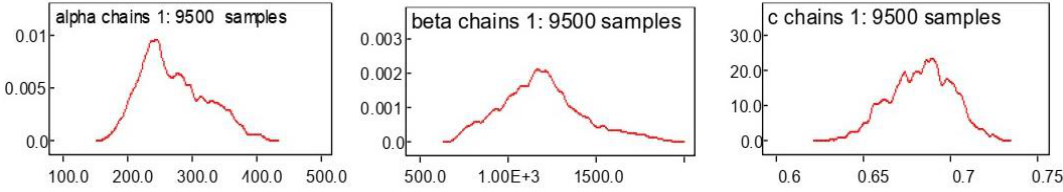
Figure 2. The fitted posterior distributions of parameters α , β , and c for 5 th sample field degradation data.